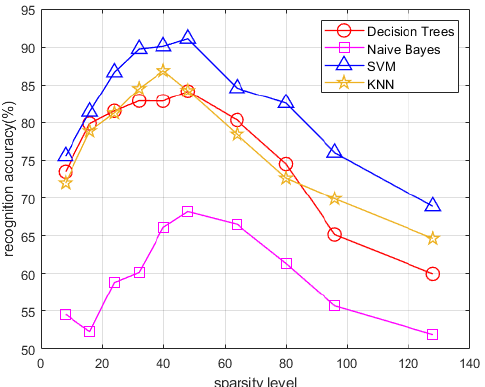
Figure 9. Recognition accuracy of the proposed method using different classifiers versus different sparsity levels.